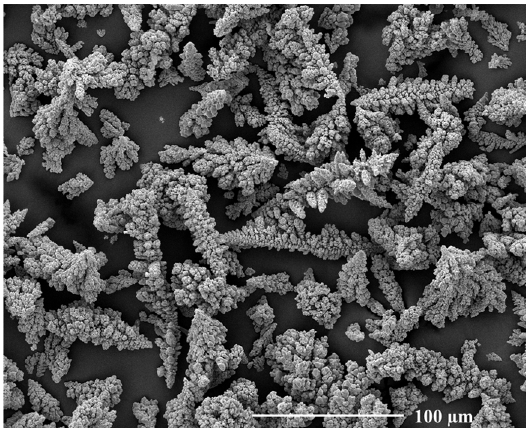
Figure 4. SEM images of copper microparticles